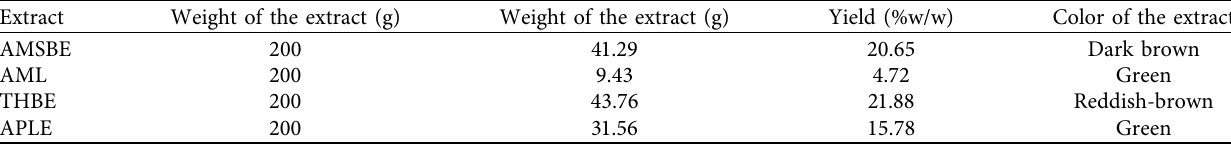
Table 1: The yield and nature of solid extracts produced.